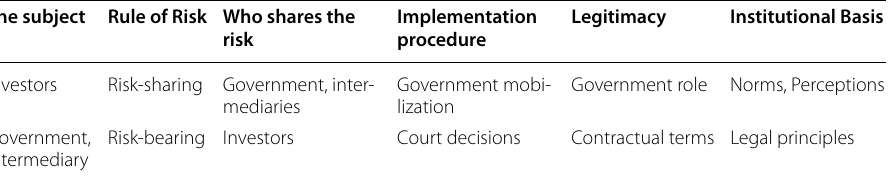
Table 1 Comparisons of the two types of risk-sharing rules The subject Rule of Risk Who shares the